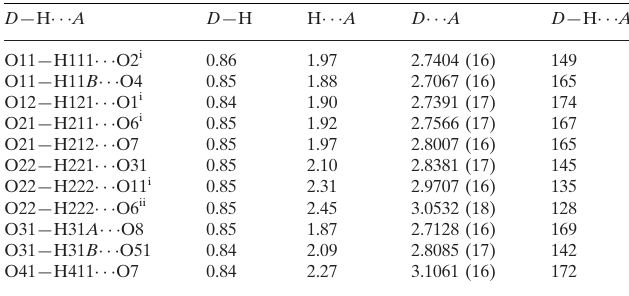
Hydrogen-bond geometry (A˚ , (cid:3)